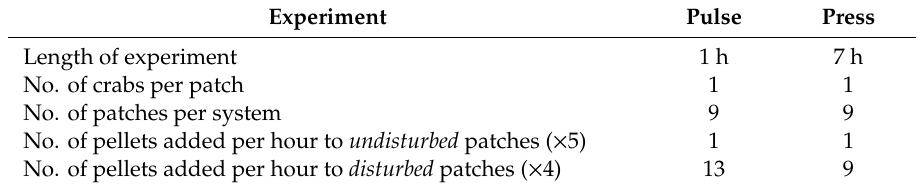
Table 2. Summary of experimental parameters for microcosms testing the e ff ect of connectivity on herbivory. Microcosms were designed so that connectivity varied between disturbed and undisturbed patches in various ways. Experiment Pulse